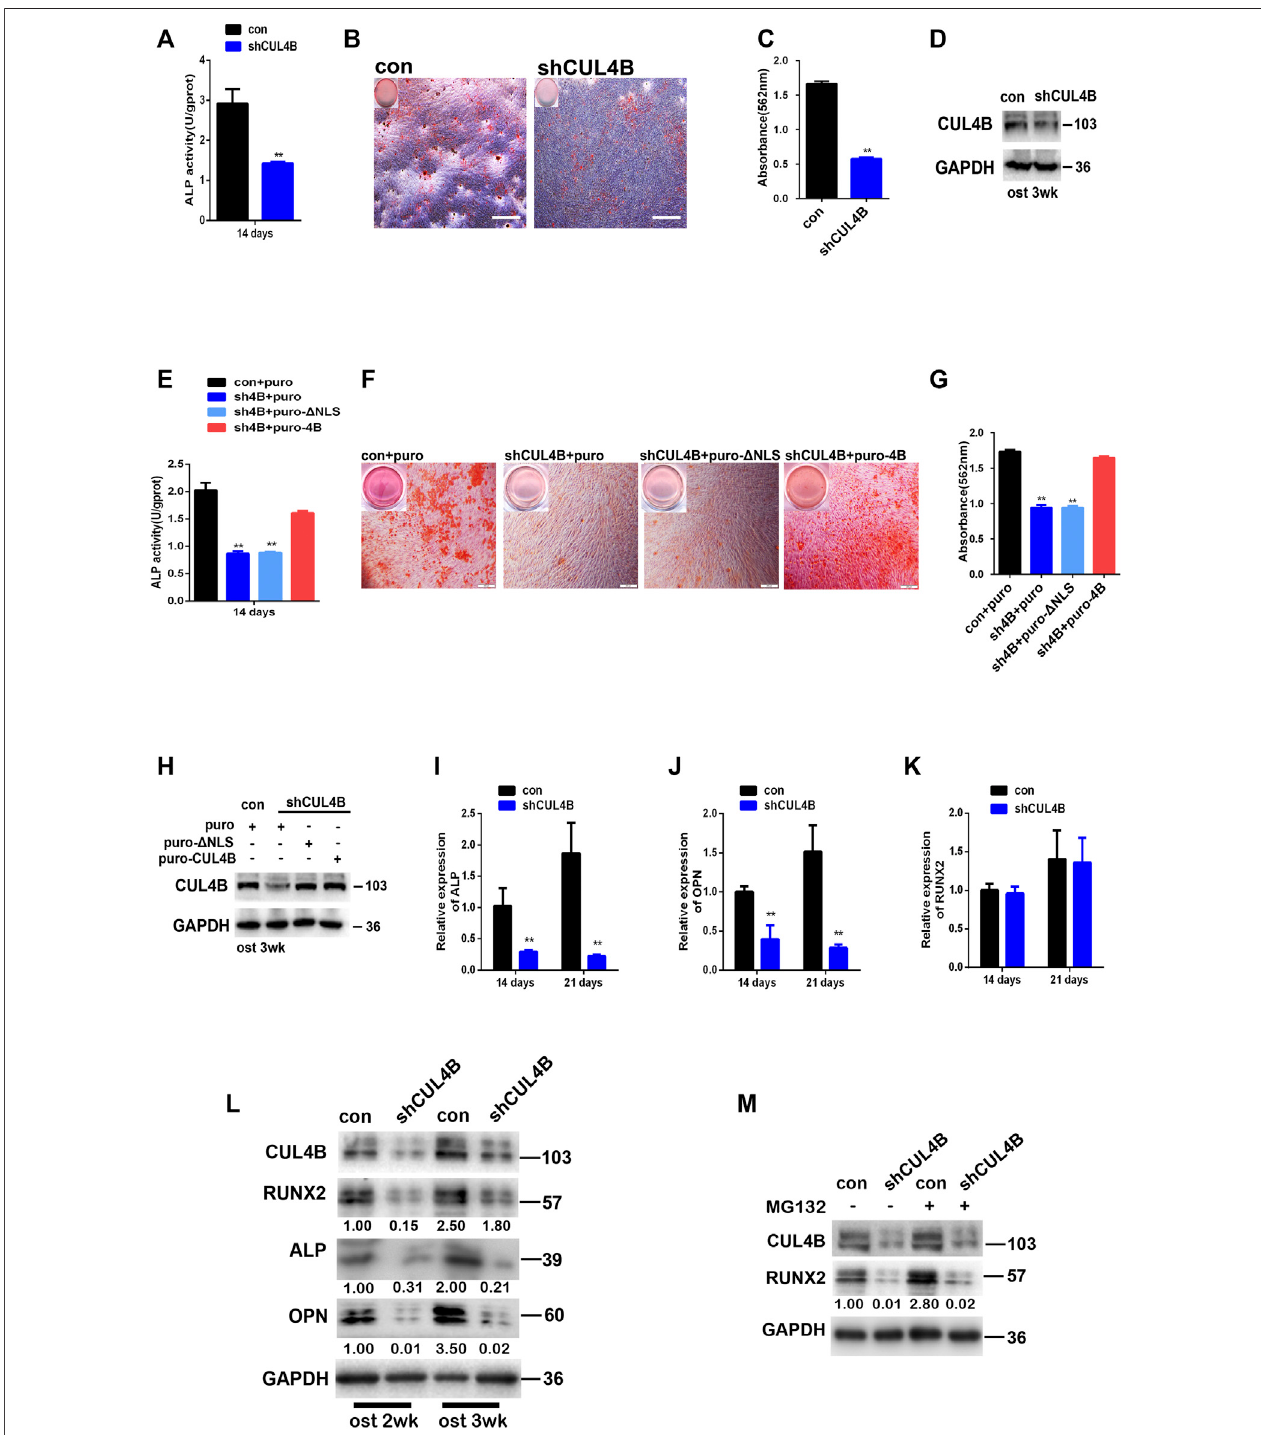
FIGURE 3 | Knockdown of CUL4B suppresses the osteogenic differentiation of PDLSCs through post-transcriptional regulation of RUNX2 protein. (A) CUL4B stable knockdown (shCUL4B) and corresponding control (con) PDLSCs were cultured in osteogenic induction medium and were collected at 14 days to measure ALP activity. (B) PDLSCs with stable CUL4B knockdown (shCUL4B) or corresponding control vector (con) were cultured in osteogenic induction medium for 21 days, and Alizarin Red staining wasperformed, scale bars: 200 μ m. (C) 10% CPC was added, and the concentration of calcium deposition was quanti fi ed by absorbance at 562 nm. (D) Western blot showing knock down ef fi ciency of CUL4B in PDLSCs after 3 weeks osteogenic induction-f CUL4B stable knockdown (shCUL4B) and corresponding control (con) PDLSCs were infected with indicated CUL4B expressing lentiviralor empty control lentiviral, indicated PDLSCs were cultured in